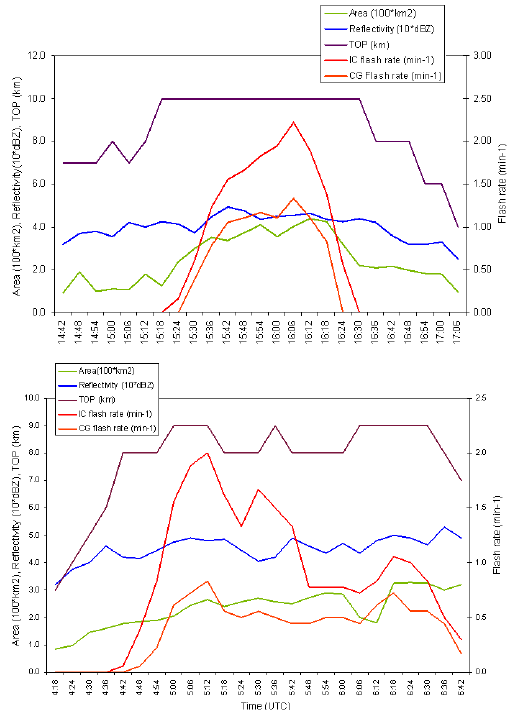
Fig. 6. Two examples of thunderstorms life cycles: single cell with a unique development (top), and a structure with more than one vertical development (successive maxima)